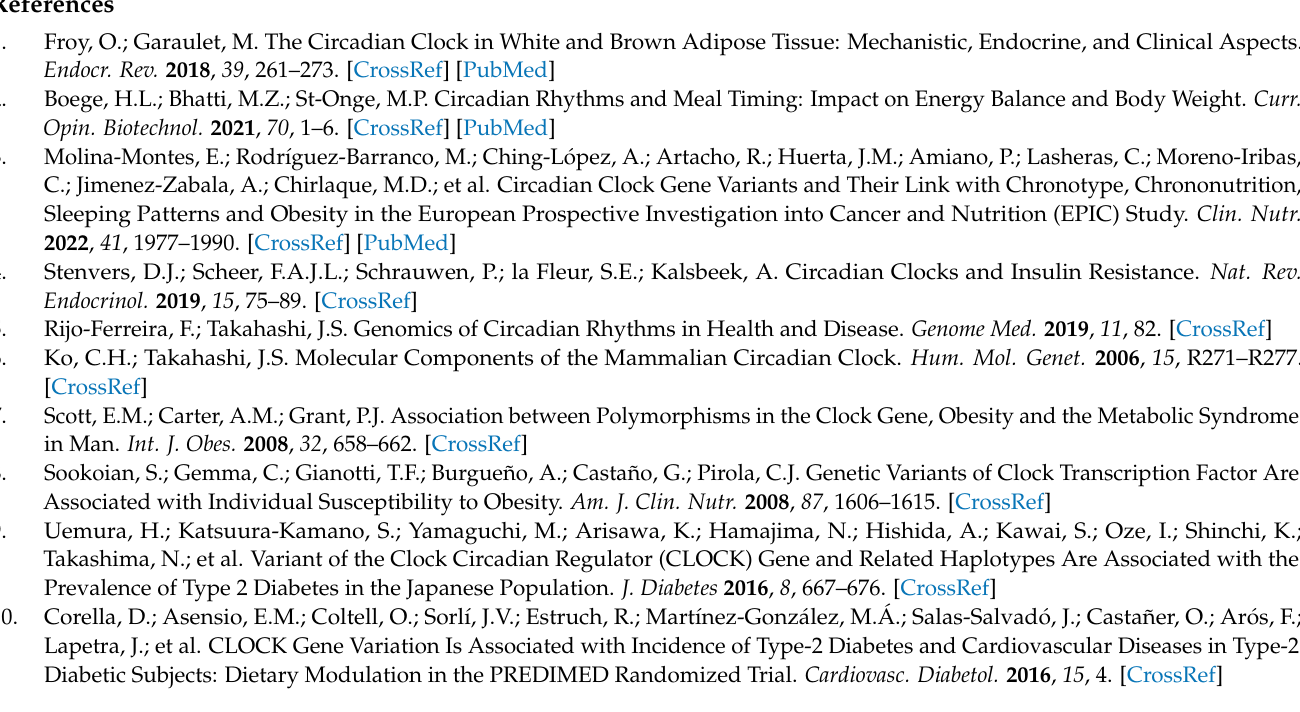
Figure S1: Association between adherence to Mediterranean diet and total sleep duration; Table S2: Prevalence of the genotypes of the SNPs studied; Table S3: Association between the selected polymorphisms and eating/sleep pattern taking into account the days of the week (weekdays or weekend); Table S4: Means, standard deviations, and p -values of body mass index (BMI) and waist circumference according to the indicated